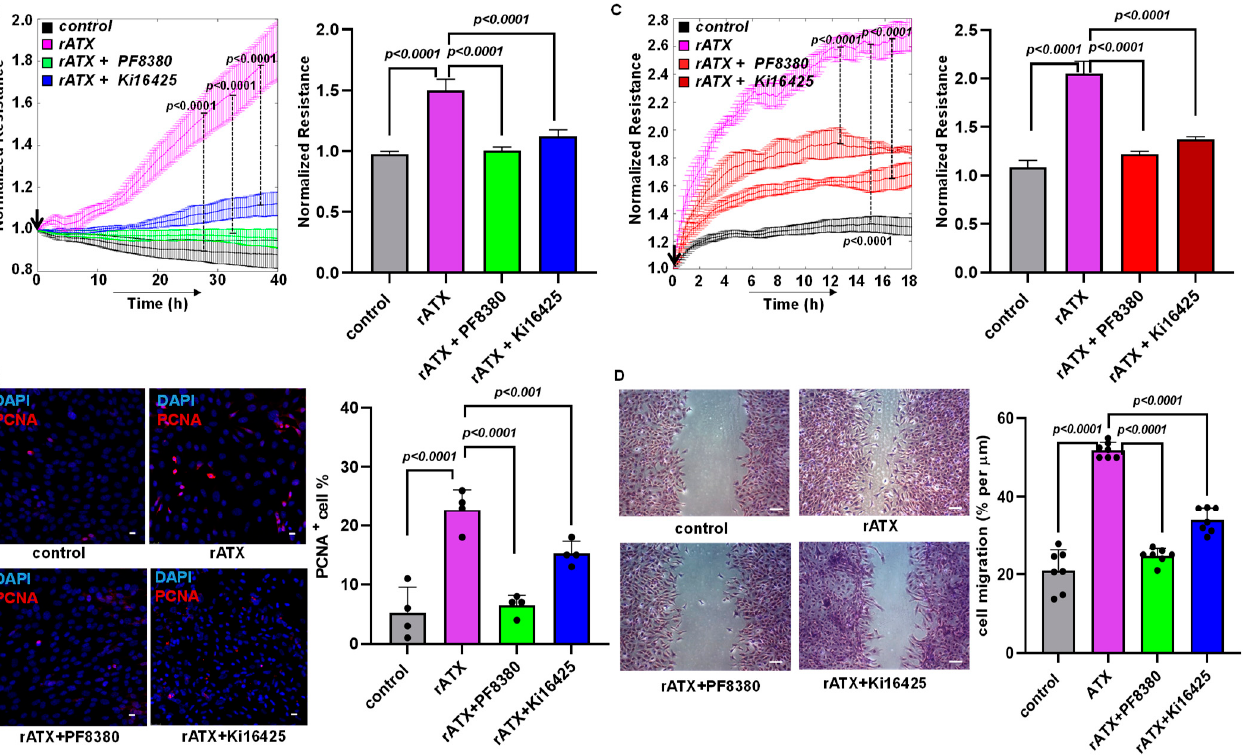
Figure 3. ATX alters VSMC proliferation and migration. ( A ) Measurement of cell proliferation using ECIS in mouse VSMCs with control (no rATX), rATX(10 nM), PF8380 (10 μ M), or Ki16425(10 μ M) treatment. All values are expressed as mean ± SD ( n = 4) with p -values calculated by one-way ANOVA. ( B ) Immunocytochemistry for PCNA in mouse VSMCs with control (no rATX), rATX (10 nM), PF8380 (10 μ M), or Ki16425 (10 μ M) treatments and quantified PCNA-positive cell percentage obtained by dividing PCNA-positive cells by the total number of cells. Scale bar = 25 μ m. All values are expressed as mean ± SD ( n = 4) with p -values calculated by one-way ANOVA. ( C ) Measurement of cell migration using ECIS in mouse VSMCs with control (no rATX), rATX(10 nM), PF8380 (10 μ M), or Ki16425 (10 μ M) treatments. All values are expressed as mean ± SD ( n = 4) with p -values calculated by one-way ANOVA. ( D ) Wound healing scratch assay was performed to measure cellular migration in mouse VSMCs with control (no rATX), rATX(10 nM), PF8380 (10 μ M), or Ki16425 (10 μ M) treatments. Scale bar = 100 μ m. All values are expressed as mean ± SD ( n = 4) with p -values calculated by one-way ANOVA. rATX—recombinant active ATX; PF8380—ATX inhibitor; Ki16425—LPAR1-3 inhibitor; PCNA—proliferating cell nuclear antigen.